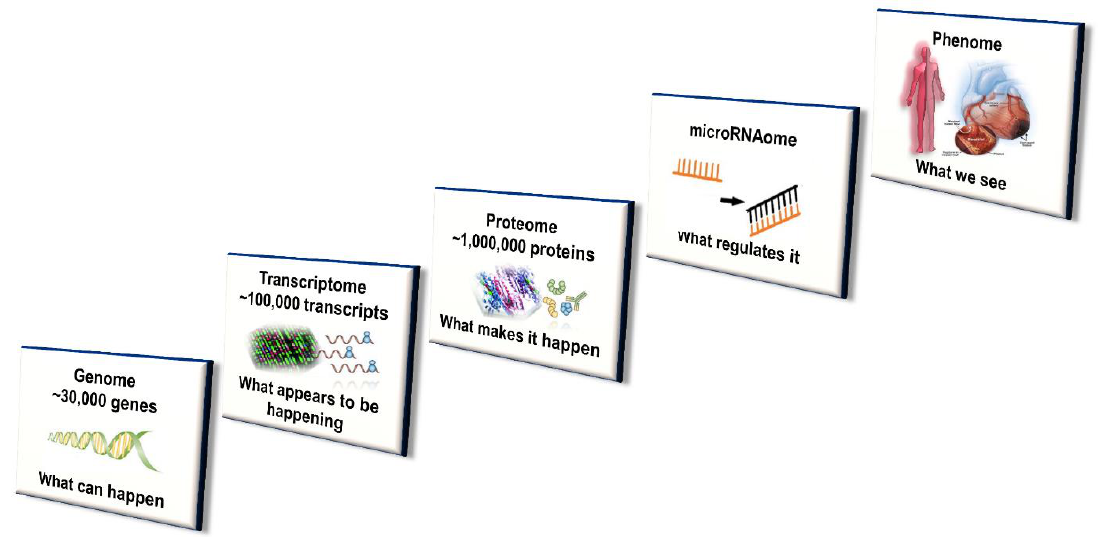
Figure 2. Multi-level systems-based approach to CYP450 expression, activity and regulation in